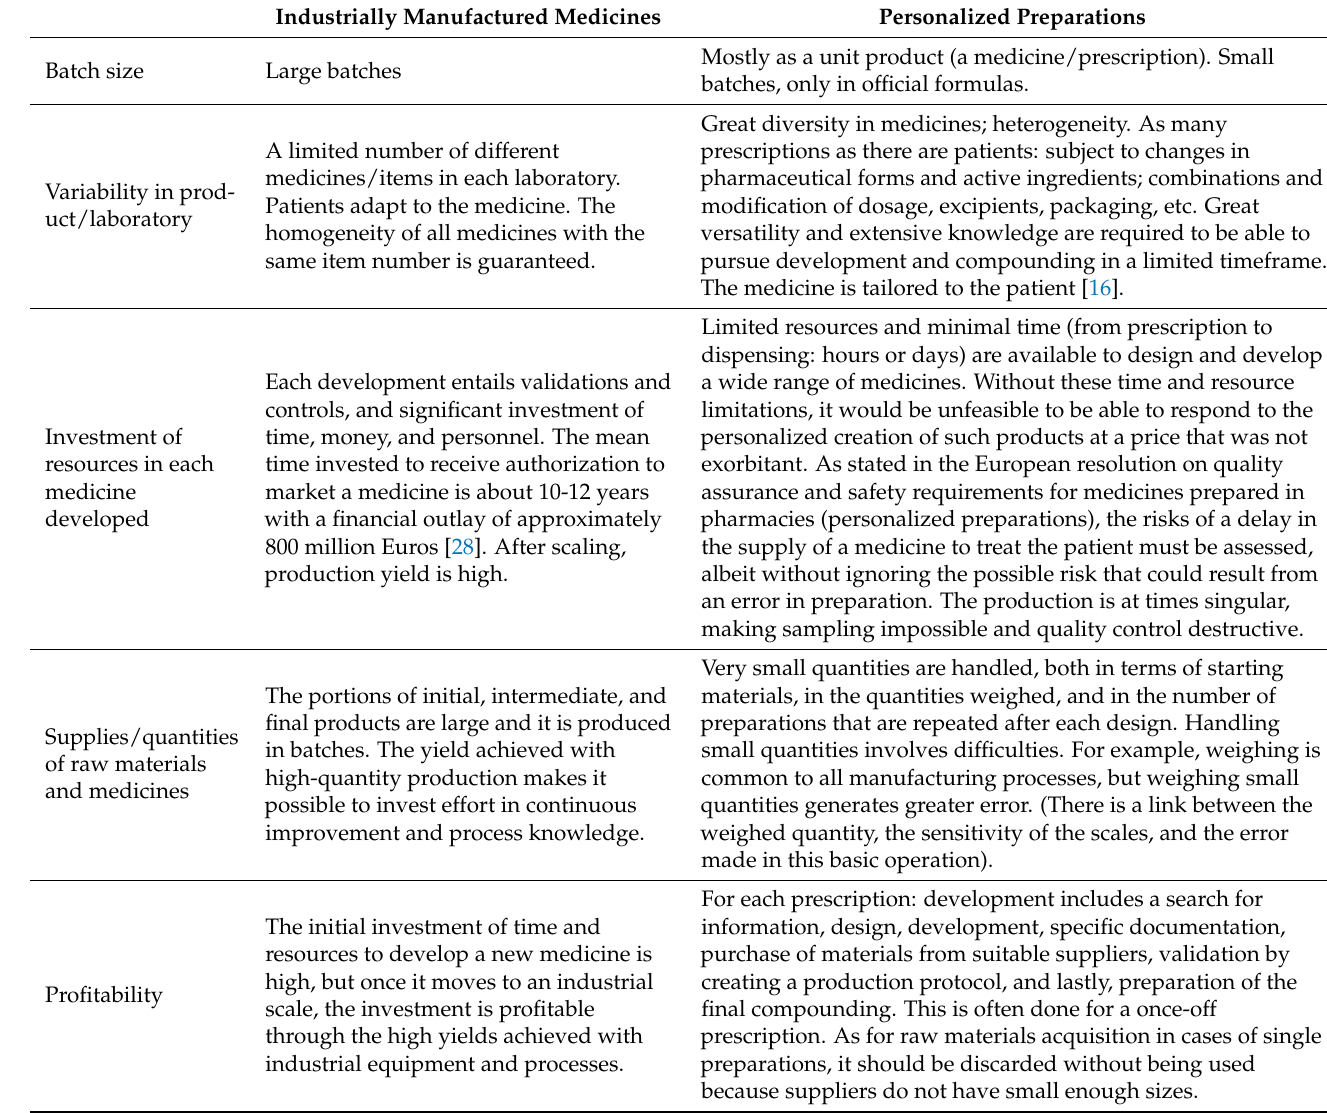
Table 2. Differential aspects of industrially manufactured medicines and personalized